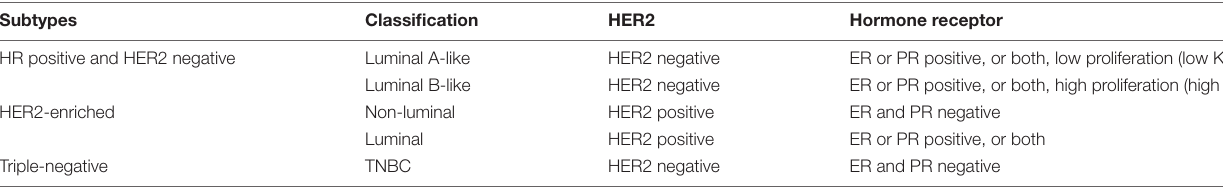
TABLE 1 | Different classifications of